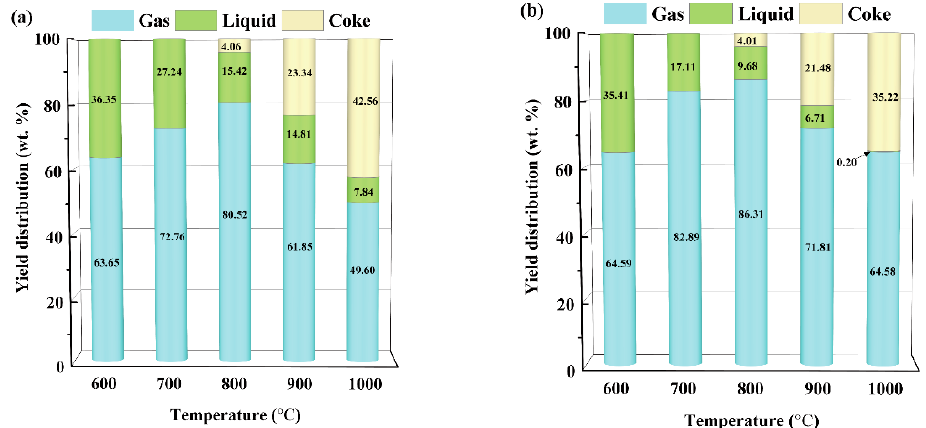
Figure 6. Gas, liquid and coke yields of WCO-Biodiesel at 600, 700, 800, 900 and 1000 ◦ C: ( a ) no CS; ( b ) with CS.